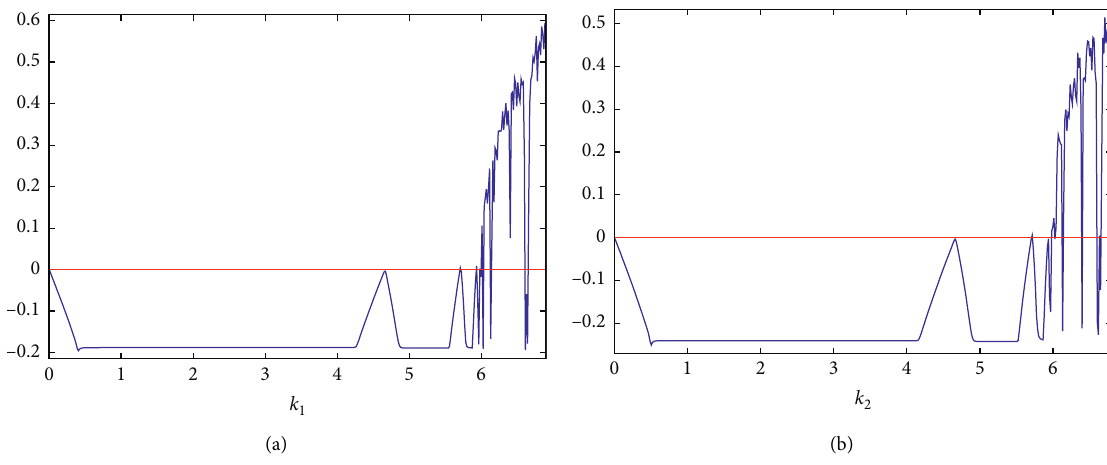
Figure 4: LLE diagram of the model with respect to k